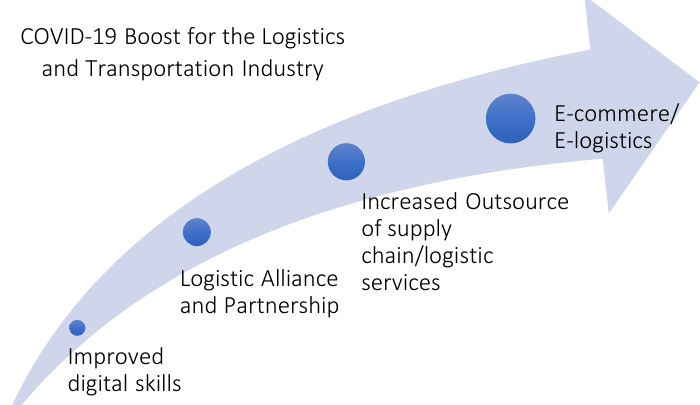
Figure 5. Positive impacts of the COVID-19 on the logistics and transportation